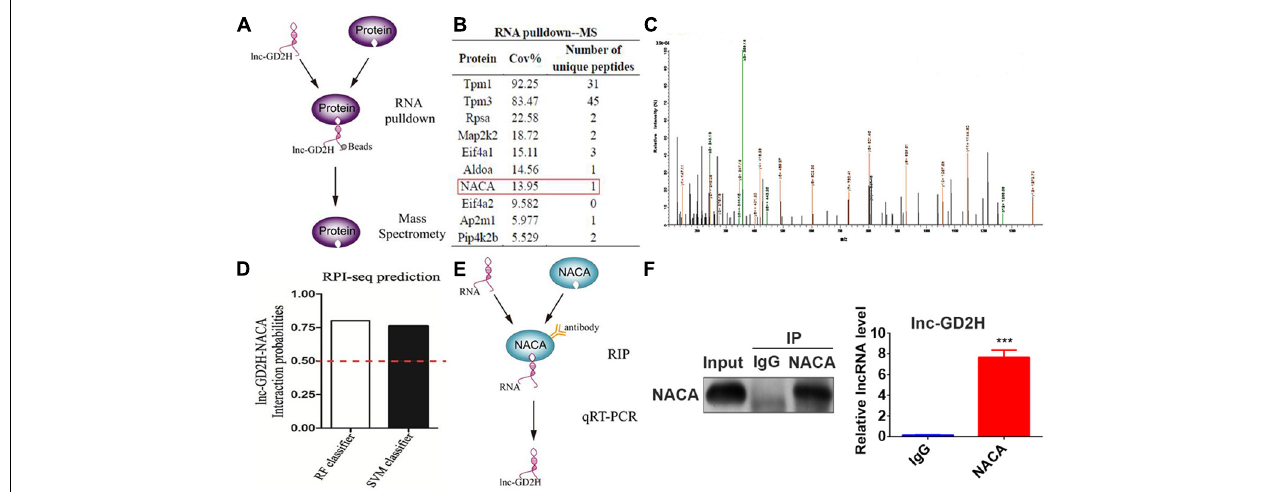
FIGURE 6 | Lnc-GD2H interacted with NACA. (A) A schematic representation of the RNA pulldown and MS assays. (B) The partial list of proteins detected using MS. (C) The NACA protein was successfully identified using MS. (D) A probable interaction between lnc-GD2H and NACA was predicted using the online tool RPISeq based on RF and SVM classifiers (probabilities > 0.5 were considered “positive”). (E) A schematic representation of the RIP assay. (F) RIP assay performed in C2C12 cells using NACA antibodies. The retrieved lnc-GD2H transcripts were assessed by qPCR. The RIP assay indicated an interaction between NACA and lnc-GD2H based on qPCR. *** P < 0.001.